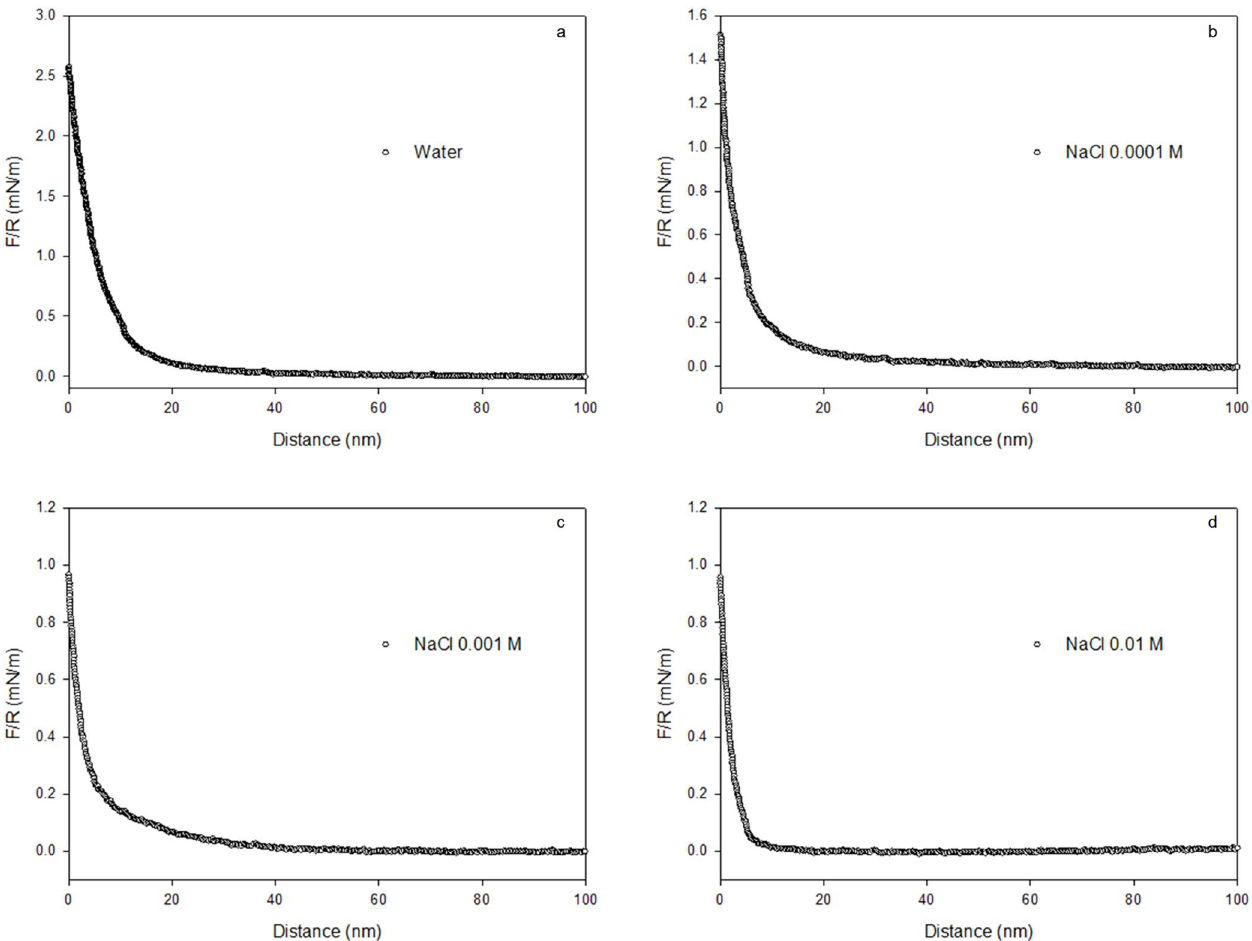
Fig 3. Approachforce curves for the interaction between BSA and PEO in a) bidistilledwater, and b) 0.0001 M, c) 0.001 M and d) 0.01 M NaCl. Each curve represents the averageof ten independentAFM measurements taken from equivalentpositions on the substrate.